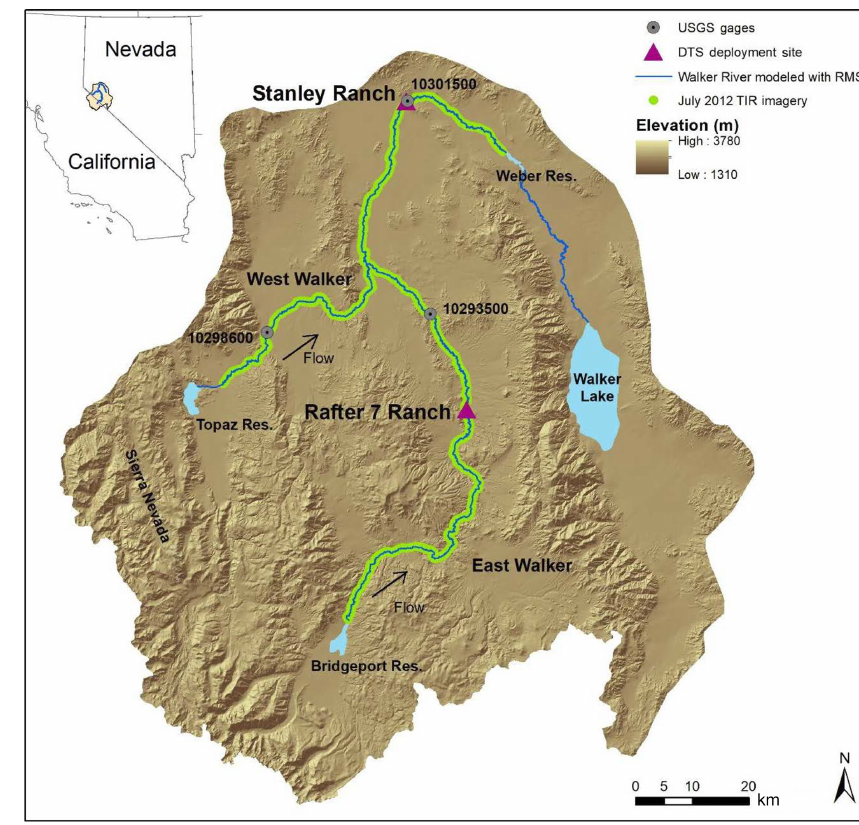
Figure 1. Walker River modeled extent, June 2015 DTS deployment sites, and July 2012 TIR imagery